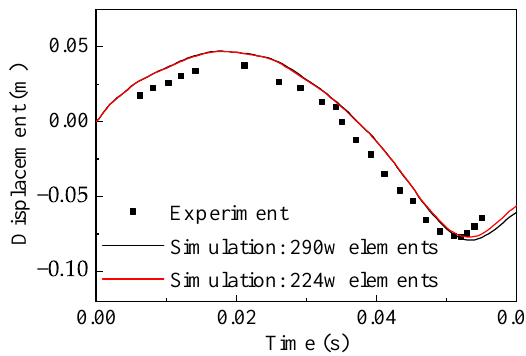
Figure 3. Displacement results of middle